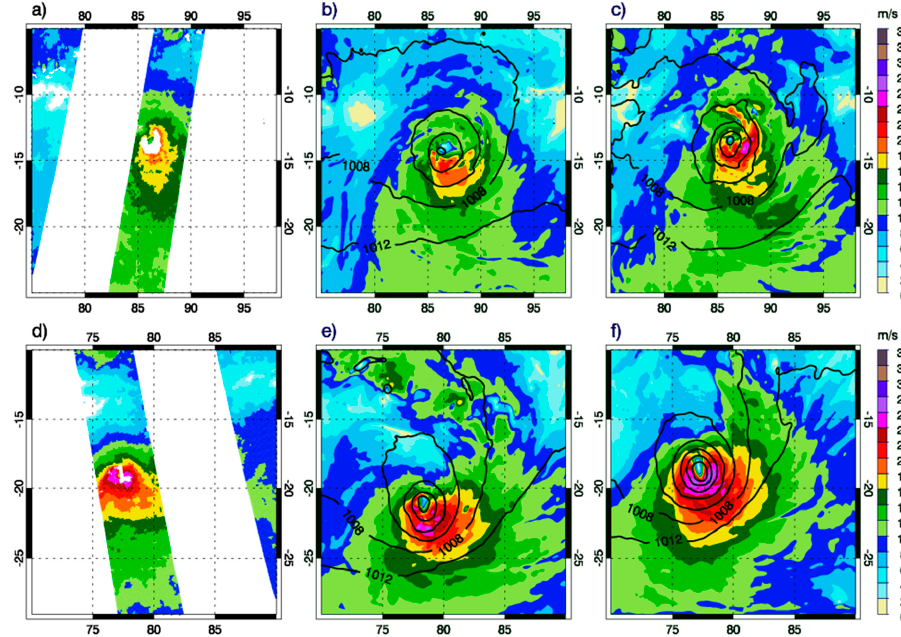
Figure 10. Surface wind speed near TC Irving from ( a ) ASCAT observation at 0302 UTC, and surface wind speed prediction overplotted with sea level pressure from ( b ) CTRL, and ( c ) DA_com at 0300 UTC on 7 January 2018; and ( d ) ASCAT at 1436 UTC, and surface wind speed with sea level pressure from ( e ) CTRL, and ( f ) DA_com at 1500 UTC on 8 January 2018.